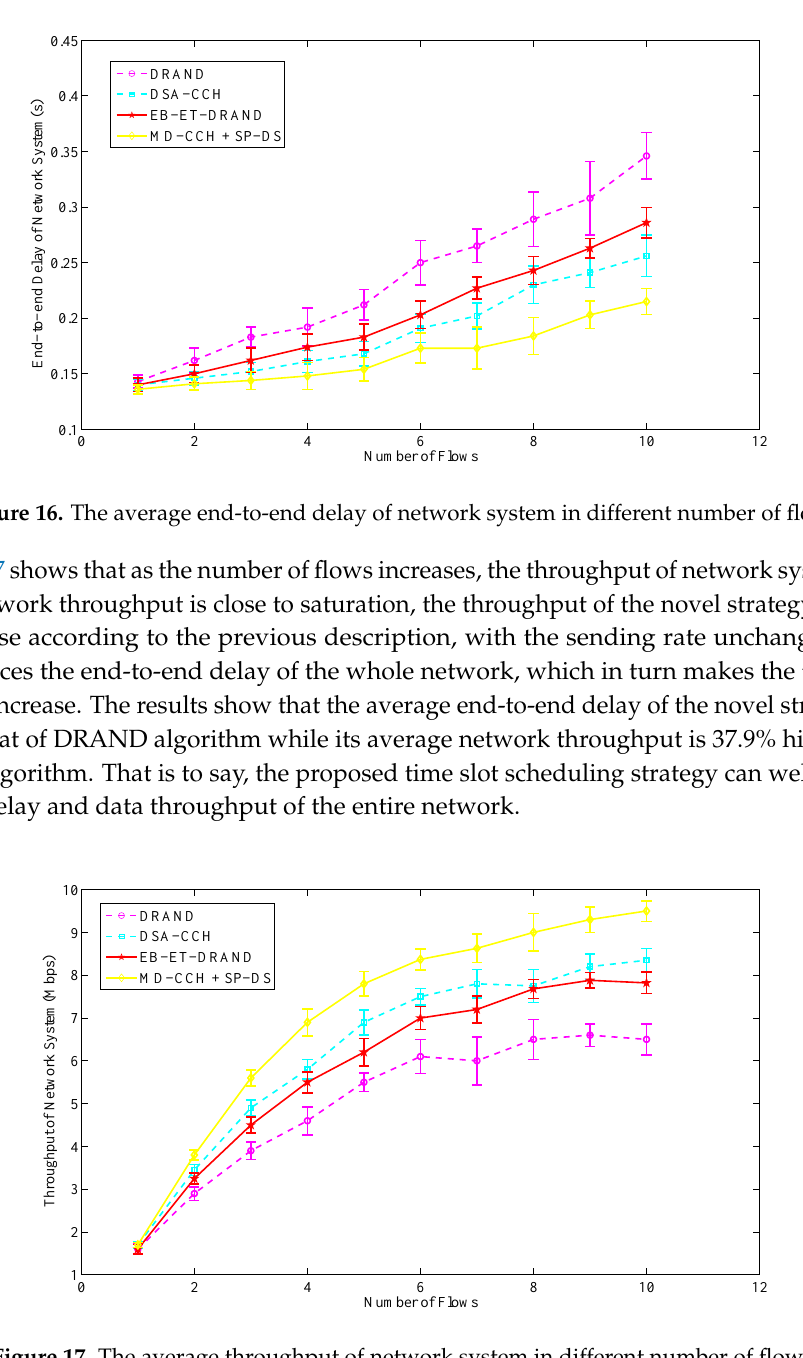
Figure 17. The average throughput of network system in different number of